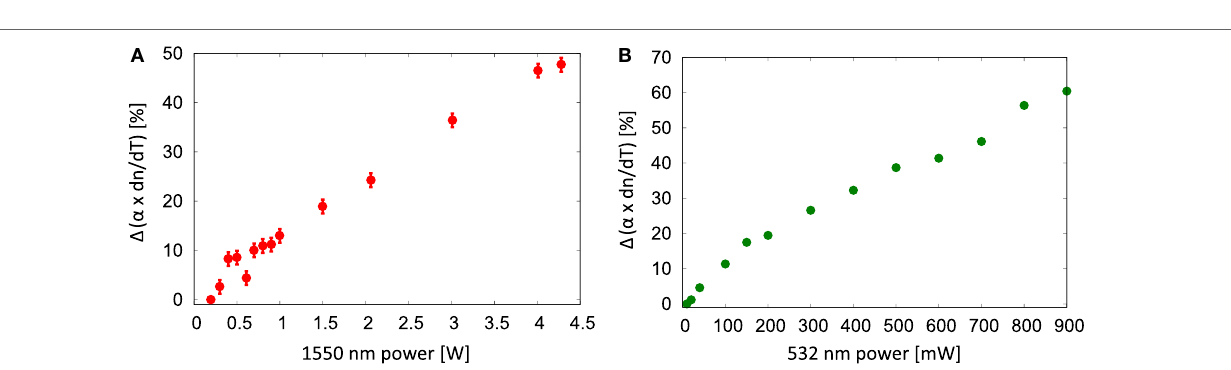
FIGURE 6 | (A) Change in (cid:11) (cid:2) dn/dT measured with varied 1,550nm (pump) beam power between 200mW and 4.3W. The 1,550nm beam is 35 (cid:22) m in diameter and hit the membrane at position 3 marked in Figure 1B . (B) Change in (cid:11) (cid:2) dn/dT measured with varied 532nm laser power heating the frame at position 1 marked in Figure 1B . The 532nm beam is about 1mm in